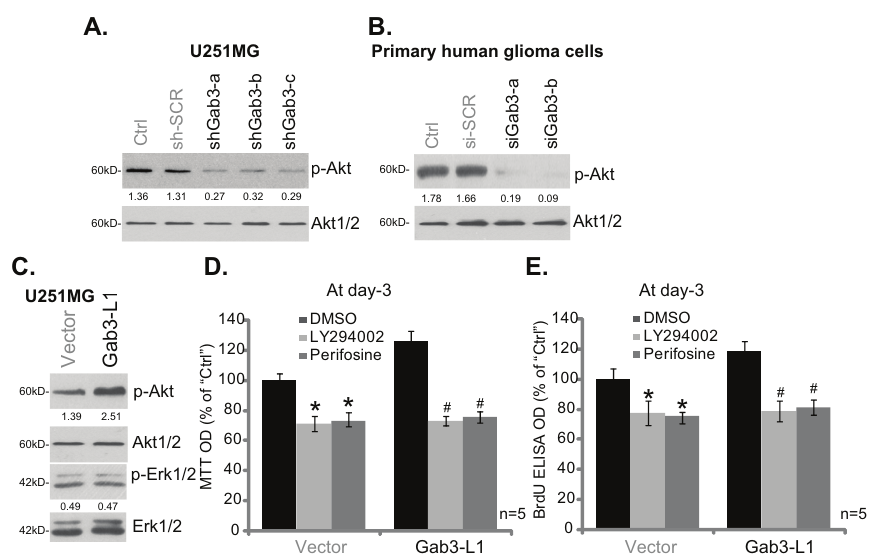
Fig 5. Gab3 is important for Akt activation in human glioma cells. U251MG glioma cells (A and C) or primary human gliomacells (B), with/out the listed Gab3 genetic manipulation, were subjectedto Western blottingassay of listed proteins. p-Akt ( vs . total Akt1/2) and p-Erk1/2 ( vs . total Erk1/2) were quantified. Stable U251MG gliomacells, expressingwt-Gab3 (two lines, “Gab3-L1”) or empty vector (“Vector”, pSuper-puro), were treated with LY294002(5 μ M) or perifosine(5 μ M), cell proliferation was tested by MTT assay (D) and BrdU ELISA assay (E).“DMSO” stands for 0.1% of DMSO. * p < 0.05 vs . DMSO of “Vector” cells. # p < 0.05 vs . DMSO of “Gab3-L1”cells.